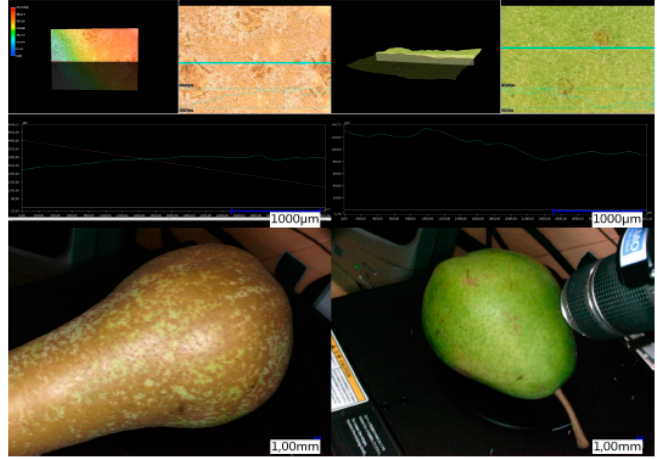
Figure 2. Determination of roughness using profile lines (blue) in the 3D microscope.